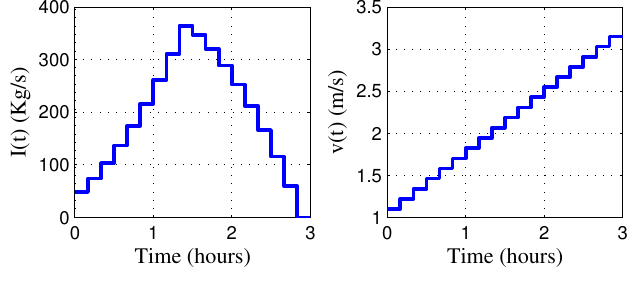
Figure 5. Input feed rate and belt speed.